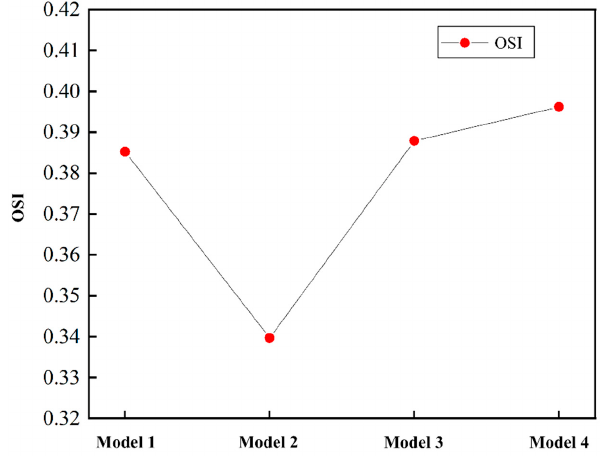
Figure 13. The oscillatory shear index (OSI) for the different models.